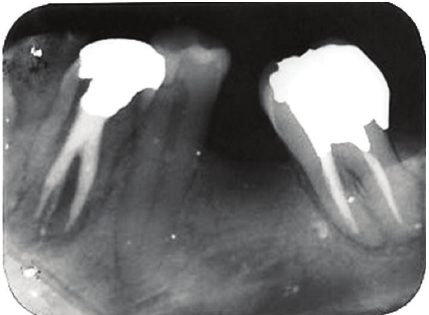
Figure 3: Radiograph revealing complete